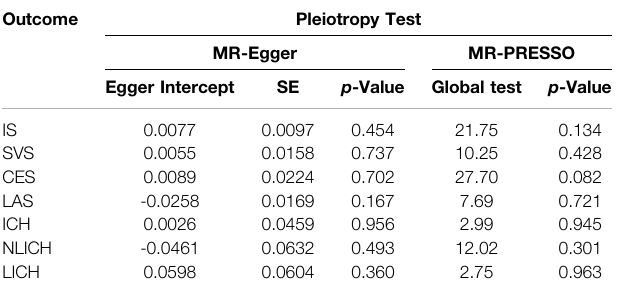
TABLE 2 | Pleiotropy Test in the causality of TIMP-3 and IS, ICH., IS = ischemic stroke, LAS = large vessel ischemic stroke, CES = cardioembolic ischemic stroke, SVS = small vessel ischemic stroke, ICH = intracerebral hemorrhage, NLICH = non-lobar intracerebral hemorrhage, LICH = lobar intracerebral